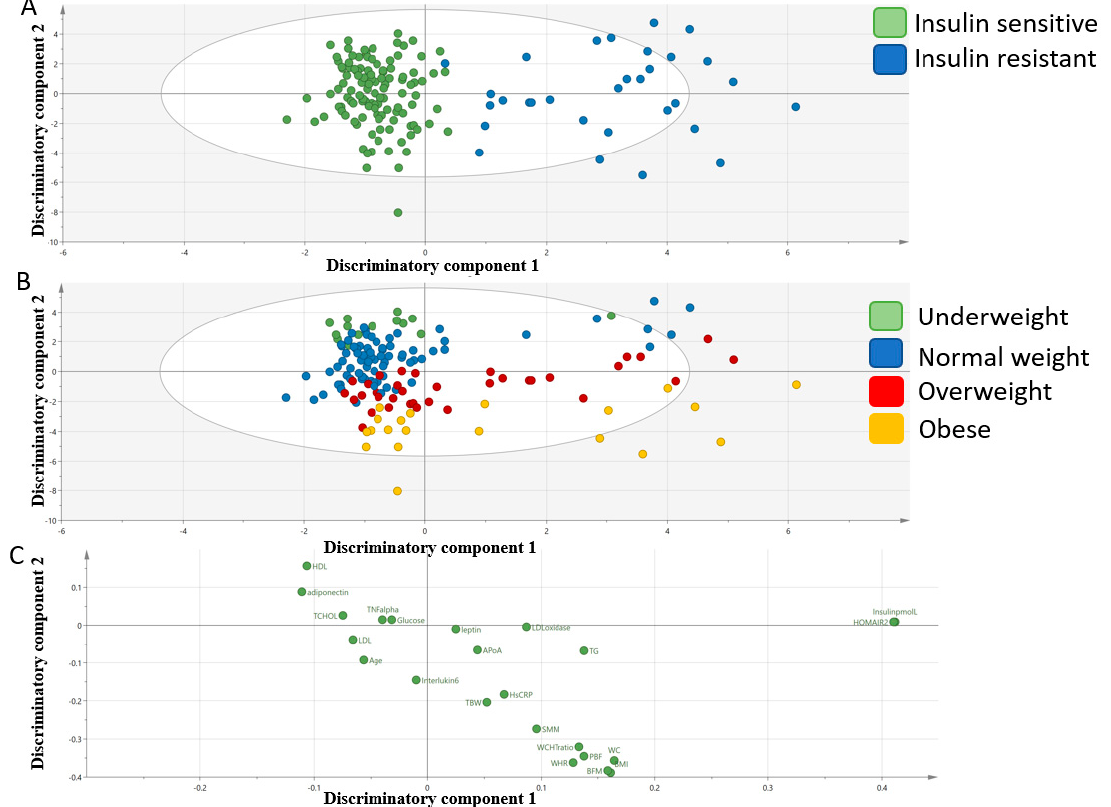
Figure 1. Orthogonal partial least square discriminate analysis (OPLS-DA) model comparing mediators of metabolic disease in IS and IR participants. ( A ). A score plot showing the class-discriminatory component 1 (x-axis) versus orthogonal component (y-axis). ( B ). An updated score plot that reveals that the orthogonal component (y-axis) mostly represent BMI groups (underweight, normal weight, overweight and obese). ( C ). The corresponding loading plot showing mediators of metabolic syndrome at either ends of the discriminatory components along the x-axis and y-axis.